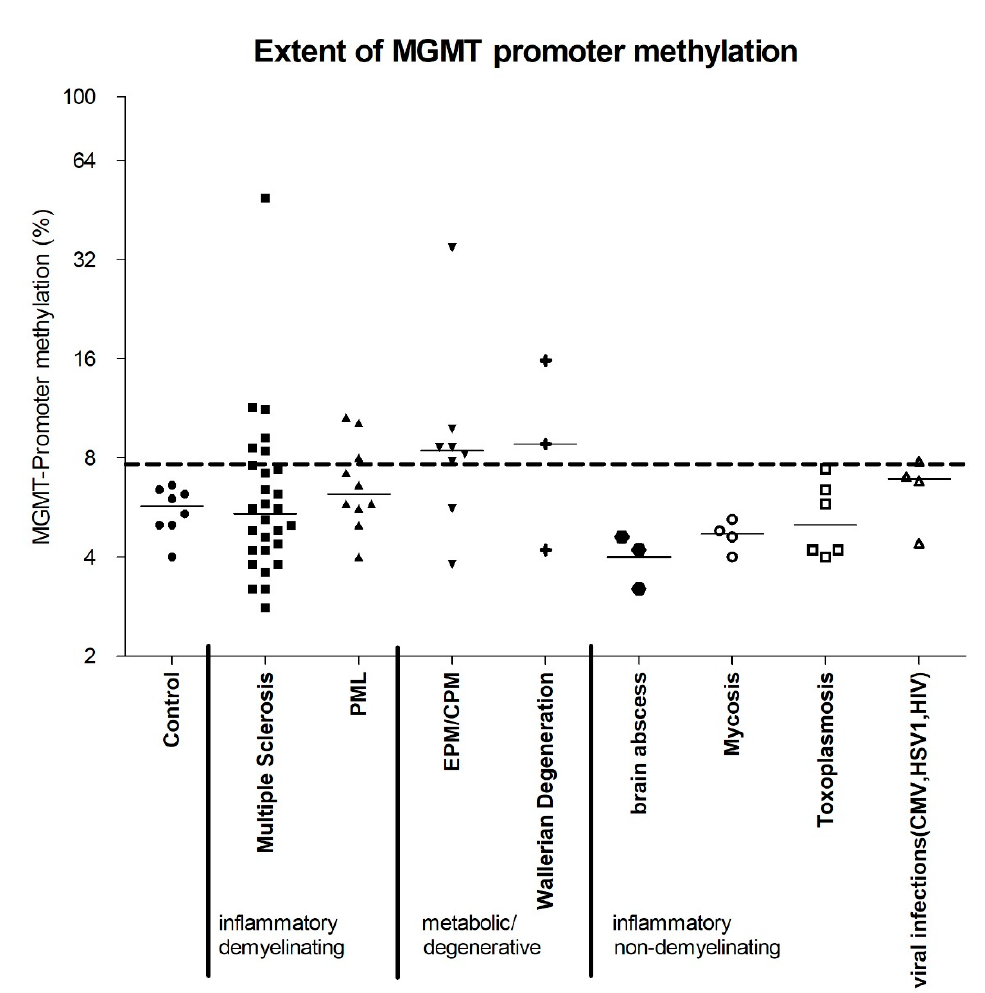
Figure 1. Summarizing evaluation of MGMT promoter methylation of inflammatory and metabolic/degenerative CNS diseases. MGMT promoter methylation status was assessed at five different CpG sites in the MGMT promoter for each demonstrated sample (control n = 8, MS n = 28, PML n = 10, EPM/CPM n = 8, Wallerian degeneration n = 3, brain abscess n = 3, mycotic encephalitis n = 4, toxoplasmosis n = 6, CMV n = 1, HSV1 n = 1, HIV n = 2). The mean of the five measurements is shown for each in Table 1. Finally, the third quartile of all mean values of non-neoplastic CNS diseases measured in our study is 7.7% methylated CpG sites in the MGMT promoters. Mean methylation values above this threshold were defined as MGMT promoter hypermethylation. Individual samples among the groups of multiple sclerosis ( n = 6/28), PML ( n = 3/10), EPM/CPM ( n = 6/8), and Wallerian degeneration ( n = 2/3) showed significantly enhanced MGMT promoter methylation compared with controls. The median of each group is shown. The methylation status of n = 71 gliomas served as a comparison for the values measured here (see Supplementary Figure S1 and Supplementary Table S1).